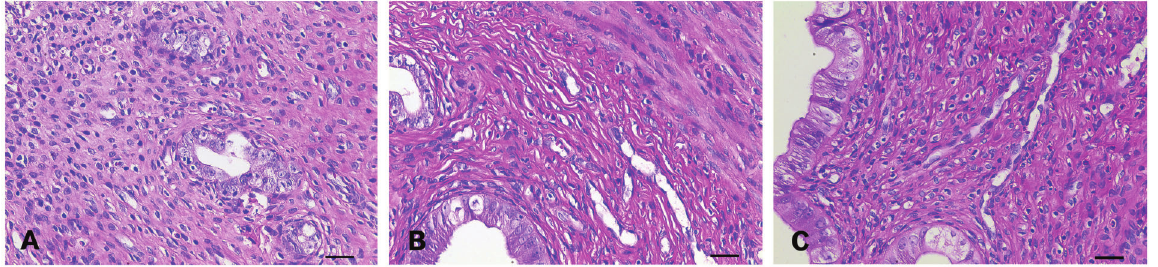
Figure 2. Representative micrographs obtained by hematoxylin and eosin stain. The original magni fi cation was 400 (cid:1) . A : NC, normal control; B : UL, uterine leiomyomas; C : UL + CRSR, treatment group with Curcumae rhizoma-Sparganii rhizoma . Magni fi cation bar: 30 m m.